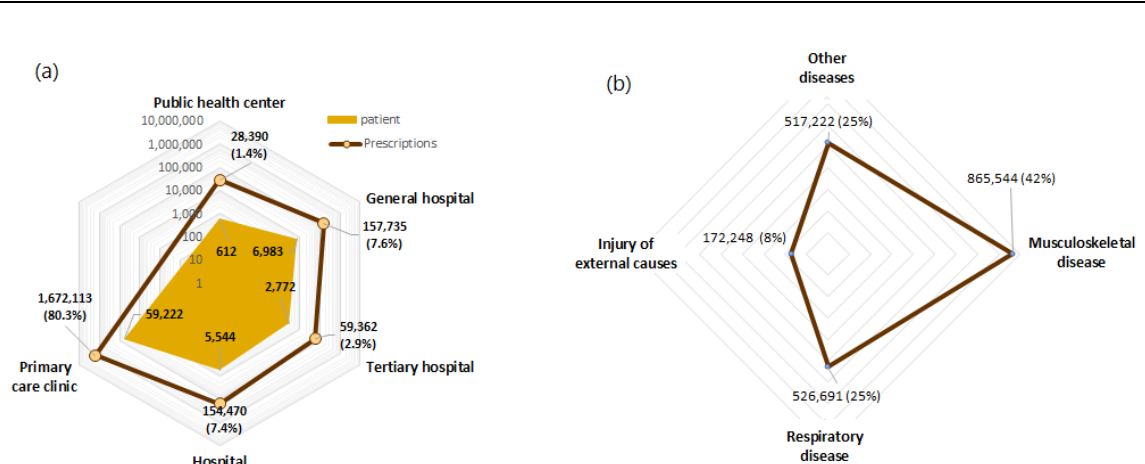
Figure 2. Trends and patterns of analgesic prescriptions with NSAIDs in ambulatory care settings among patients with a history of MI: ( a ) Type of medical institution and the number of analgesic prescriptions/patients. ( b ) The proportion of prescriptions with NSAIDs for each indication among patients with incident MI (2008–2015).